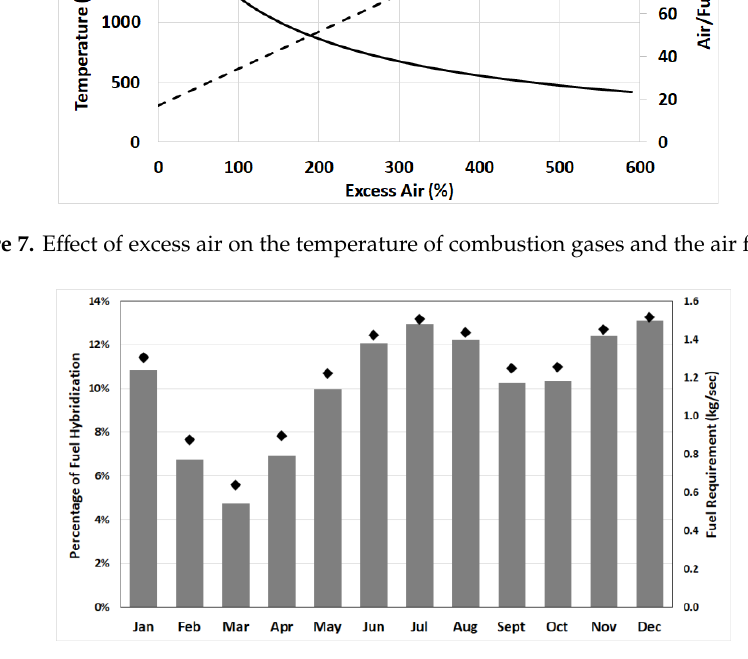
Figure 8. Percentage of fuel hybridization (bars) and fuel required (dots), in kg/s, to maintain steady operation of the cycle from 8 a.m. to 4 p.m.